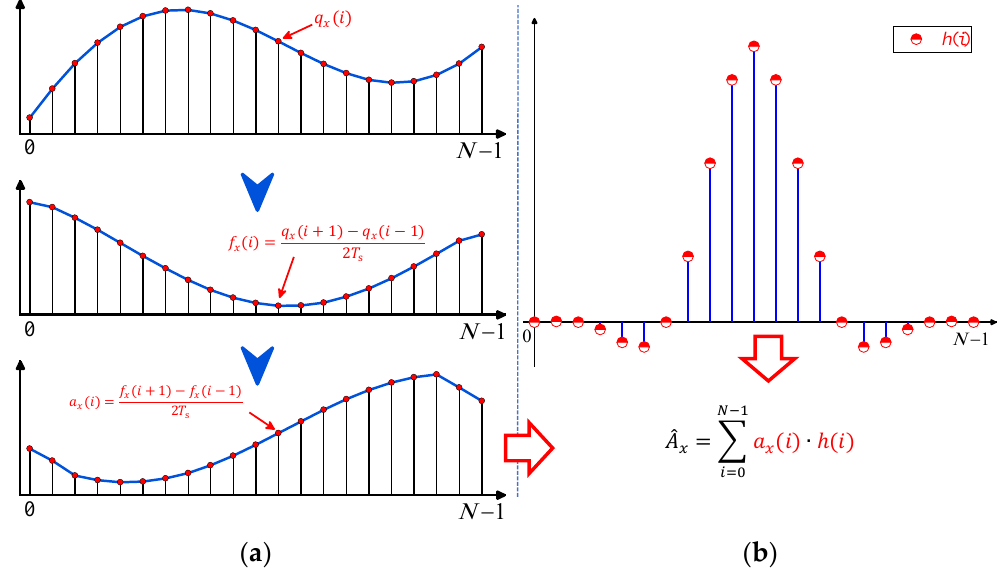
Figure 4. The process of solving the acceleration of X-axis: ( a ) the process of calculating the acceleration sequence; ( b ) the process of filtering the acceleration